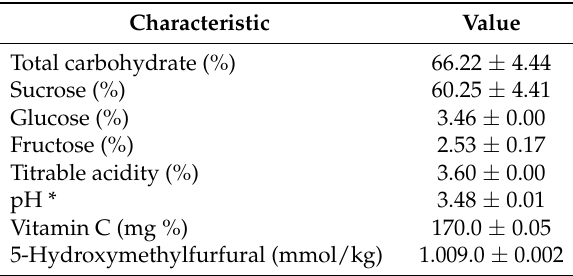
Table 3. Chemical properties of oil palm syrup.